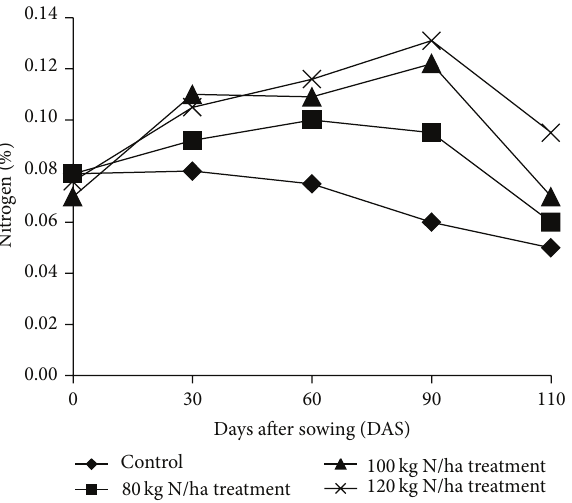
Figure5:NitrogenstatusofsoilwithdifferentratesofN-application at different irrigation intervals